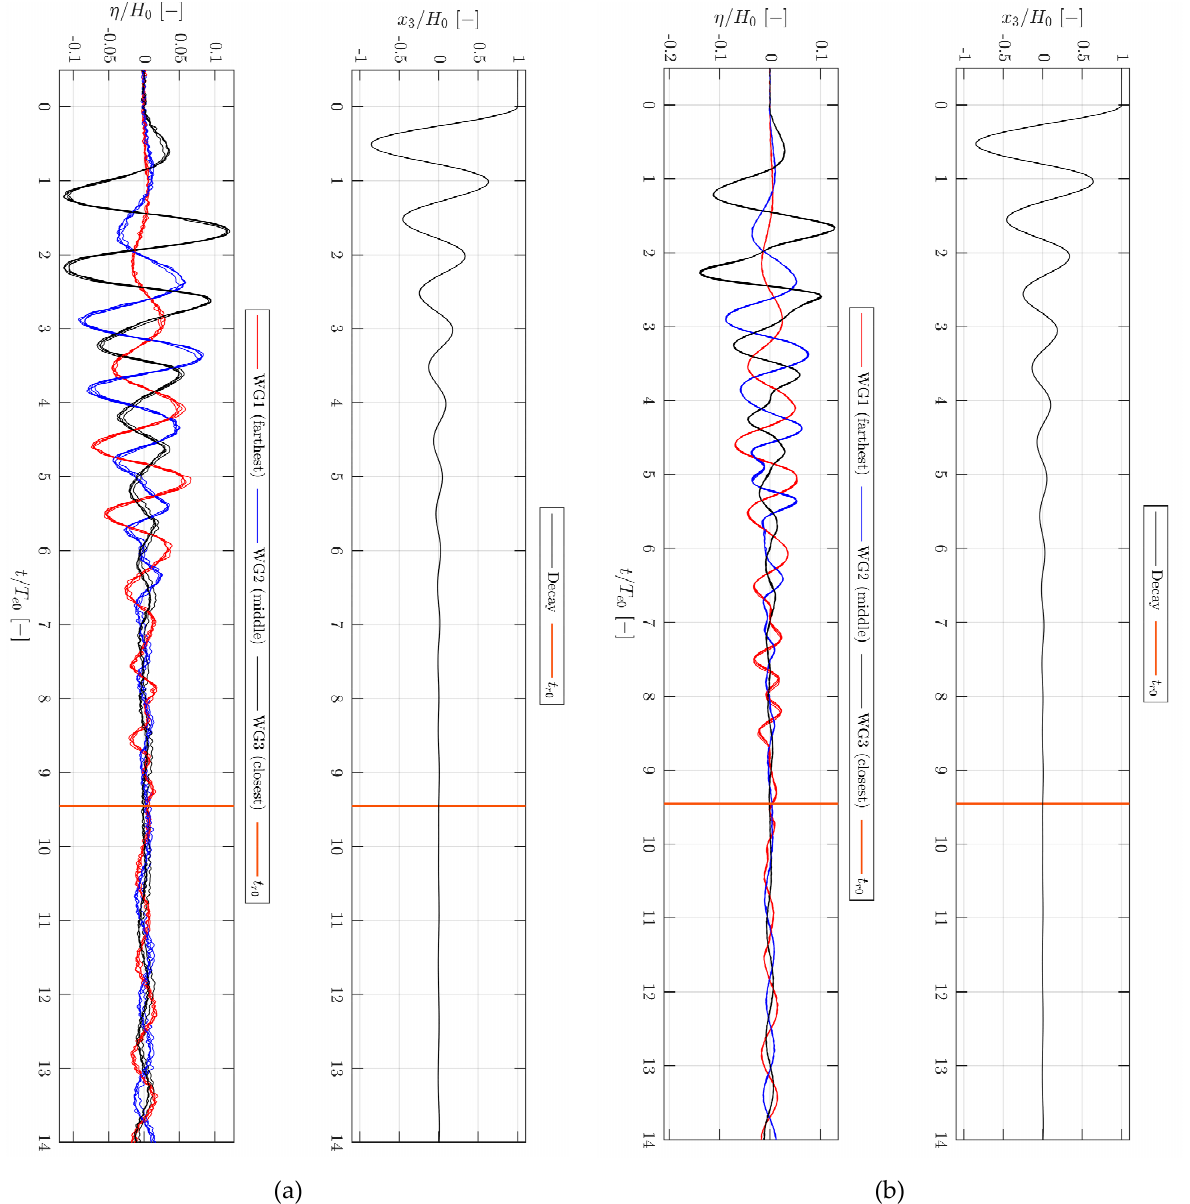
Figure A9. Surface elevation time series for tests with 𝐻 (cid:2868) = 0.1𝐷 ( a ) and 𝐻 (cid:2868) = 0.3𝐷 ( b ).